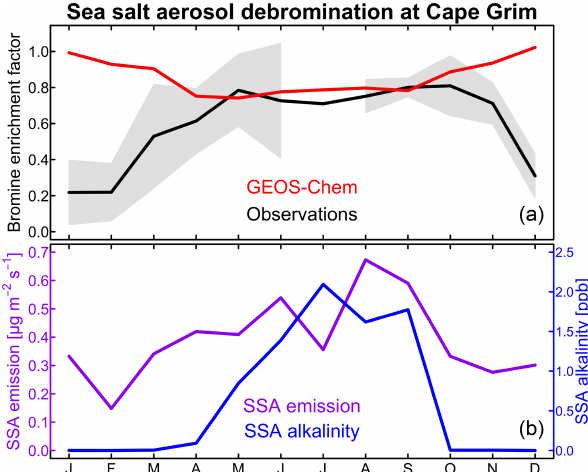
Figure 2. Seasonal variation of sea salt aerosol (SSA) debromi- nation at Cape Grim, Tasmania (40.7 ◦ S, 144.7 ◦ E). (a) shows the bromine enrichment factors (EFs) of monthly mean SSA in surface air. Observations from Ayers et al. (1999) and Sander et al. (2003) for 1996–1998 are compared to GEOS-Chem model values for 2012. Shading gives the interannual standard deviation in the obser- vations. (b) shows the GEOS-Chem monthly SSA emission flux at Cape Grim (site 3 in Fig. 1) and the SSA alkalinity. The SSA emis- sion flux is for the oceanic fraction of the Cape Grim grid